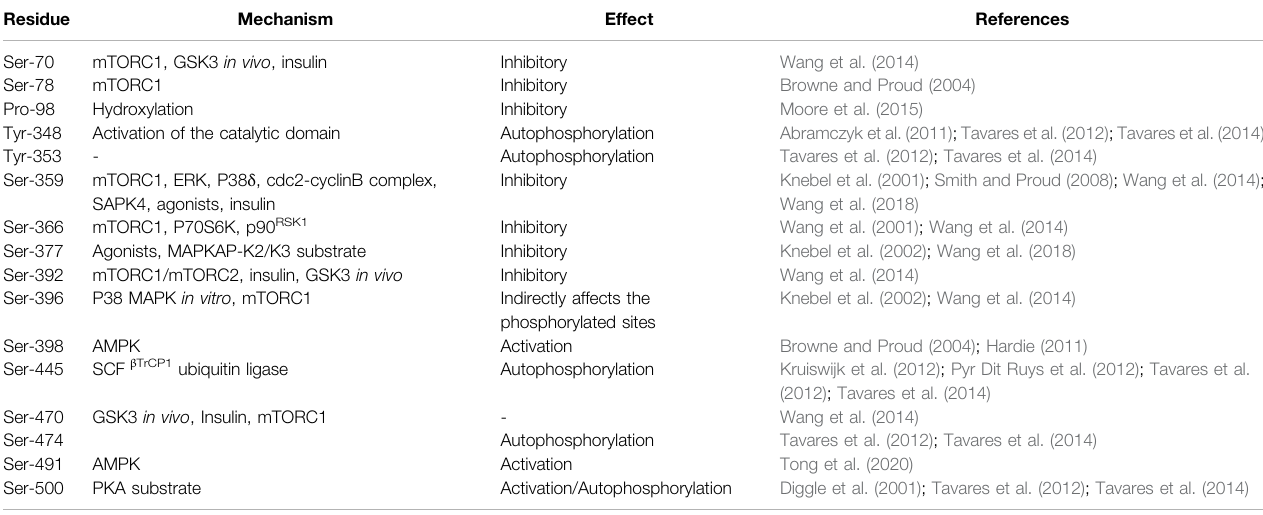
TABLE 1 | eEF2K phosphorylated sites with their effect and mechanism.